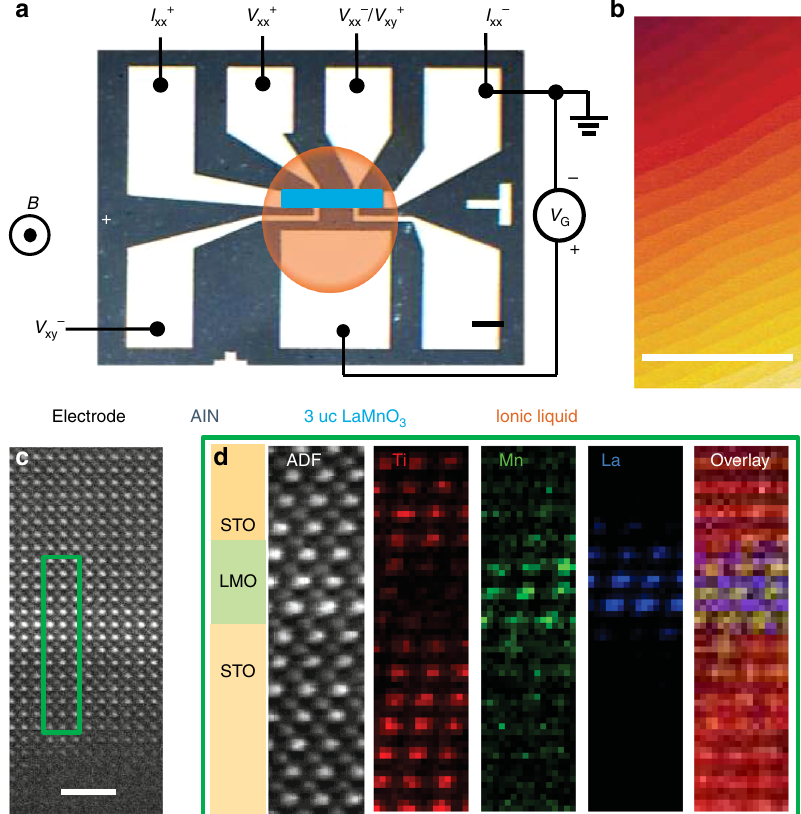
Fig. 1 Schematic and structural characterization of the electric double-layer transistor. a Schematic of the device, fabricated by ultraviolet lithography. The exposed area of LaMnO 3 is 300 µ m in length and 50 µ m in width. The scale bar is 100 µ m. b Atomically fl at surface of 3 unit cell (uc) LaMnO 3 fi lm grown on a SrTiO 3 (001) substrate characterized by atomic force microscopy. The scale bar is 1 µ m. c High-angle annular dark fi eld (HAADF) image of the SrTiO 3 - capped sample. The scale bar is 2 nm. d EELS of the SrTiO 3 -capped sample. The corresponding EELS region is indicated in the green box in the HAADF image ( c